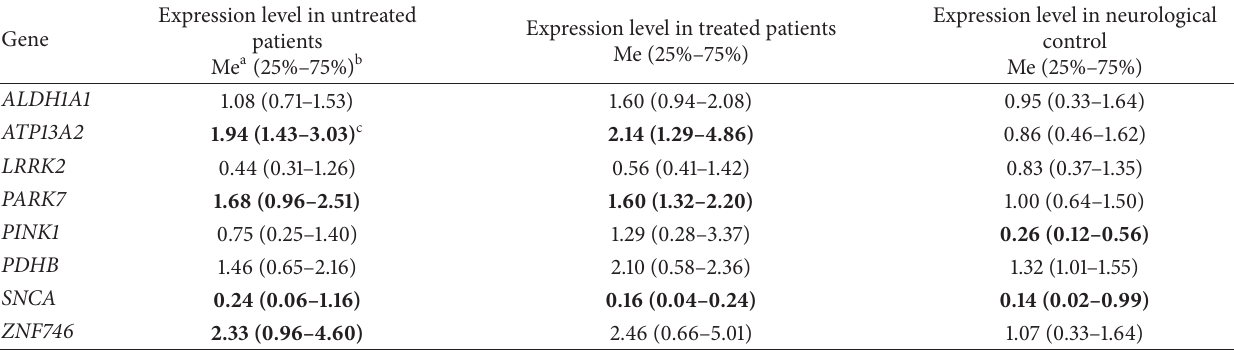
Table 2: Relative expression levels of the genes